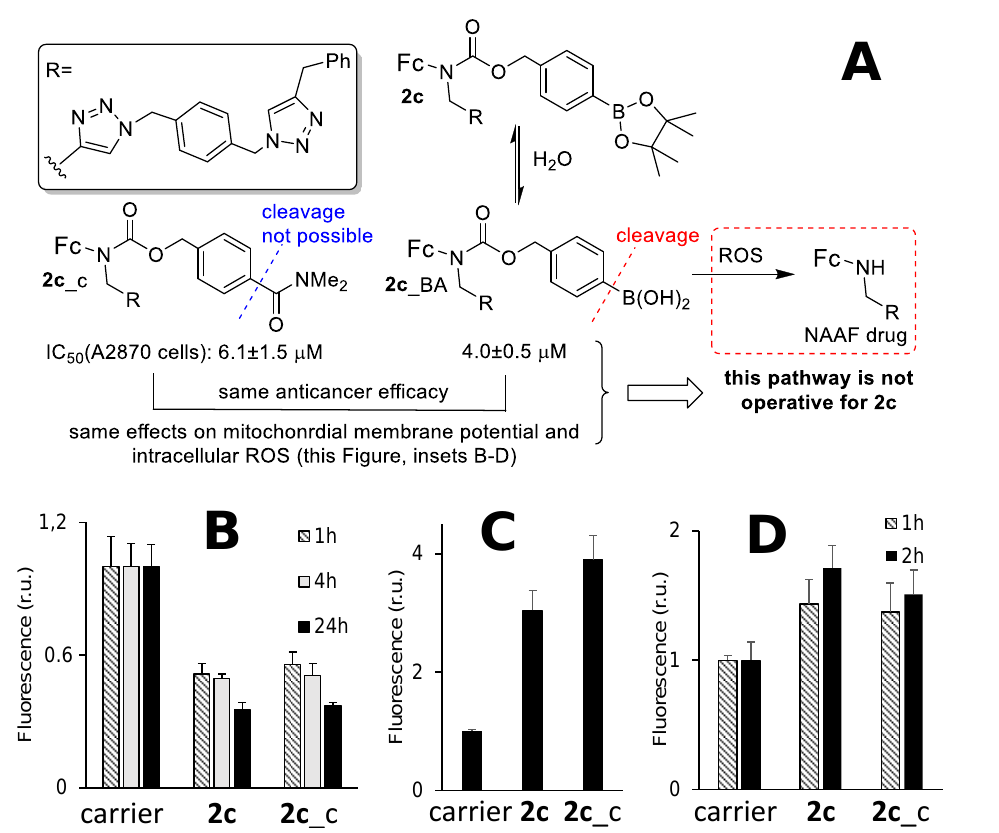
Figure 5. ( A ) An outline of the possible pathway of activation of 2c in cells: first, hydrolysis occurs with formation of 2c_BA, second, ROS-induced activation occurs with formation of the NAAF drug. ROS-resistant control 2c_c and 2c have identical cellular effects ( B – D ). Therefore, the ROS-induced 2c_BA activation is not operative for prodrug 2c. Effects of carrier (DMSO, 1%, v / v ), 2c (5 µM) and 2c_c (5 µM) on ( B ) MMP (Fluorescence = F t (prodrug)/F t (carrier), where F: λ ex = 488 nm, λ em = 530 nm, r.u. = relative units, probe: R123, incubation time t = 1, 4, 24 h as indicated on the plot); ( C ) total ROS (tROS, same detection parameters as in B, probe: CM-DCFH-DA, t = 2 h) and ( D